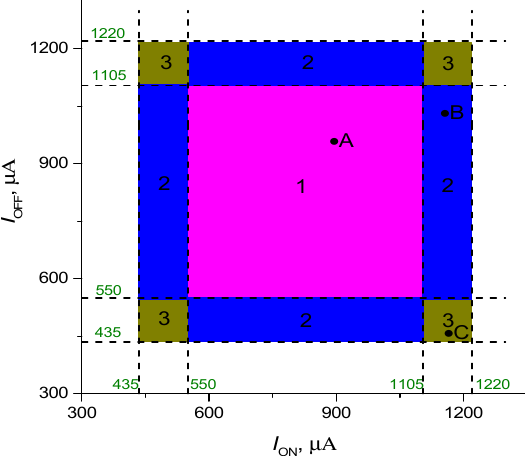
Figure 11. Ranges of current variation for I ON and I OFF with division into areas (area 1, area 2, area 3). Area 2 corresponds to the case when one of the current levels I ON or I OFF leads to generation, while the other level sets the oscillator to the sub-threshold